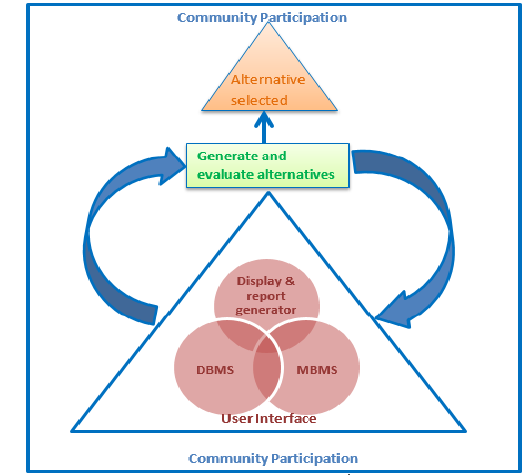
Figure 2 Geospatial Decision Support system designed for Slum development